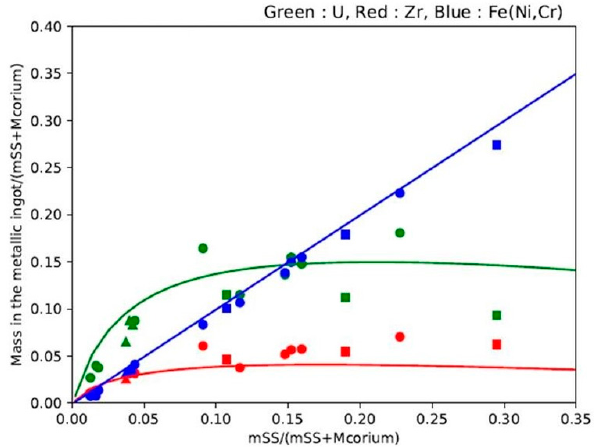
Figure 7. Comparison between NUCLEA (full lines) and the measured compositions of the metallic phases in uranium (green), zirconium (red) and iron (or stainless steel) (blue) from the MASCA 1 and MASCA 2 Projects for PWR C 32 corium.